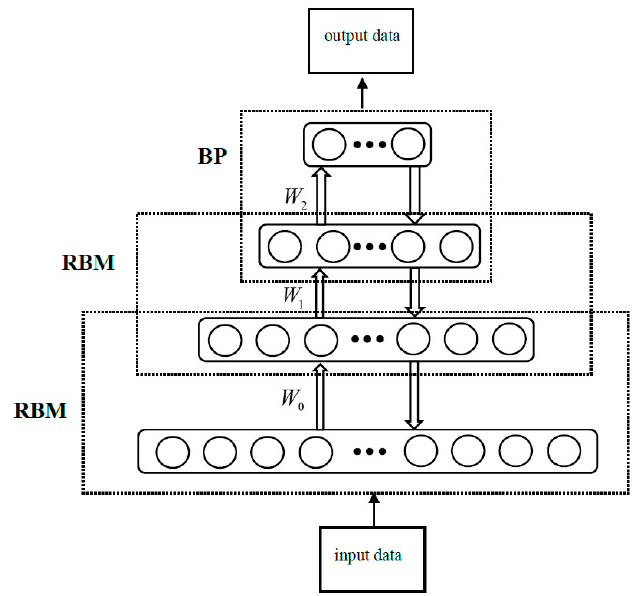
Figure 7. The structure of Deep Belief Networks (DBNs).